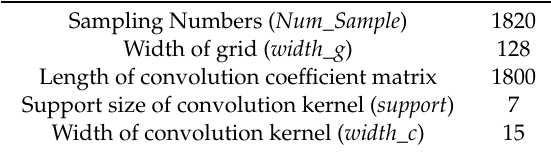
Table 3. Data characteristics in small-scale acceleration